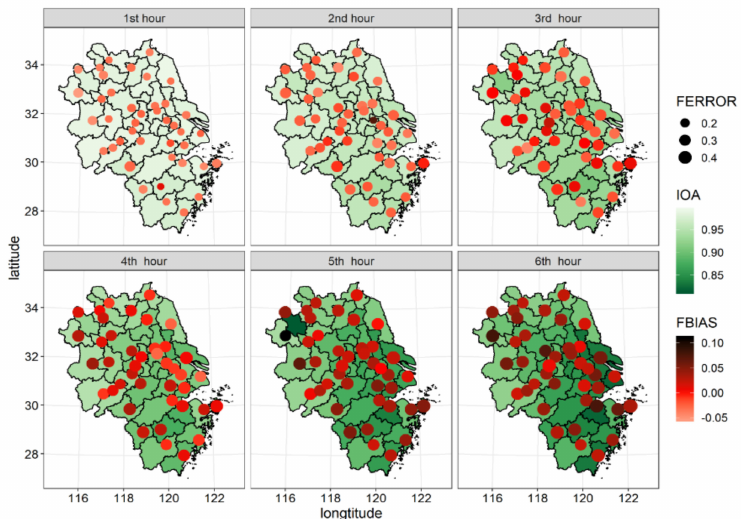
Figure 6. Distributions of fractional bias (FBIAS), fractional error (FERROR) and index of agreement (IOA) over cities with the variation of forecast